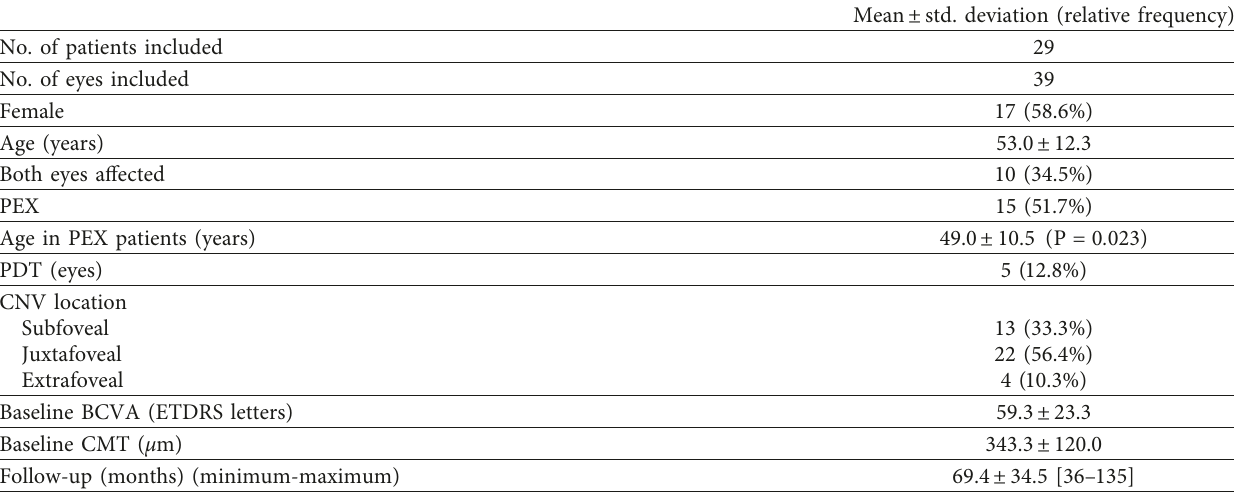
Table 1: Demographic and baseline characteristics of patients with choroidal neovascularization secondary to angioid streaks.